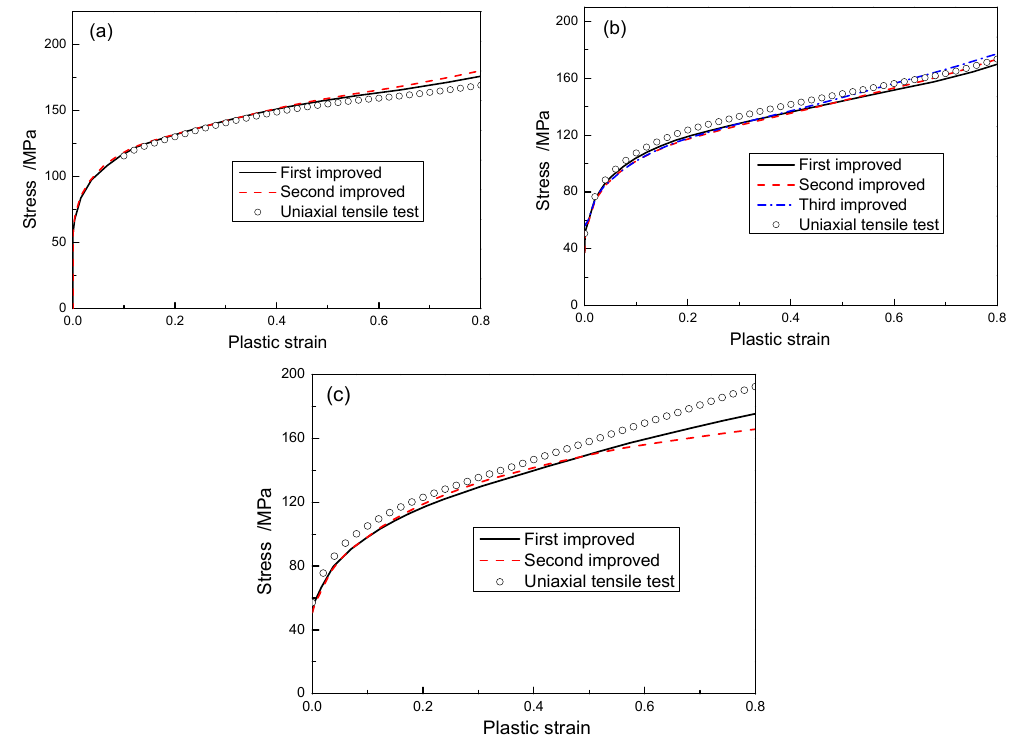
Figure 15. Improved stress-plastic strain curves and uniaxial test data at different strain rates. ( a ) 0.1 s −1 ( b ) 0.02 s −1 ( c ) 0.005 s −1 .